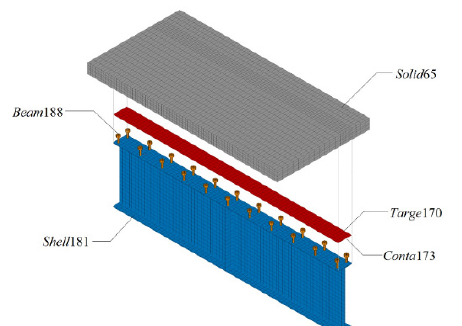
Figure 5. Types of elements adopted in numerical